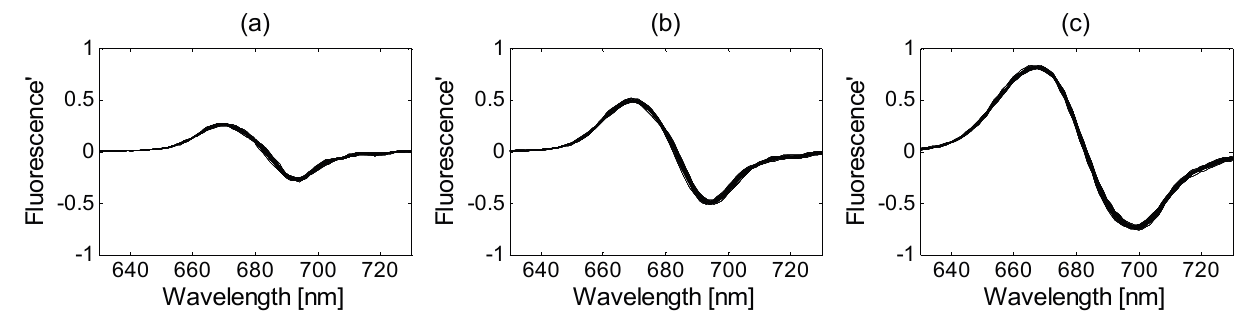
Figure 9. Derivative of the Thwi samples for different band separation: ( a ) 5 sampling intervals; ( b ) 10 sampling intervals; ( c ) 20 sampling